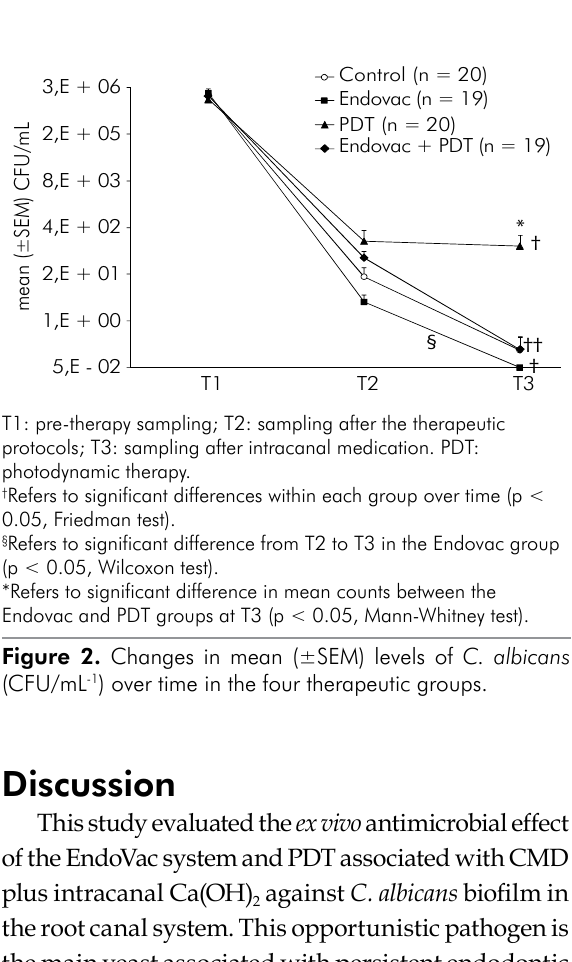
Figure 1. Distribution of pre-therapy (T1) levels of C. albicans (CFU/mL-1) in contaminated teeth of four therapeutic groups.